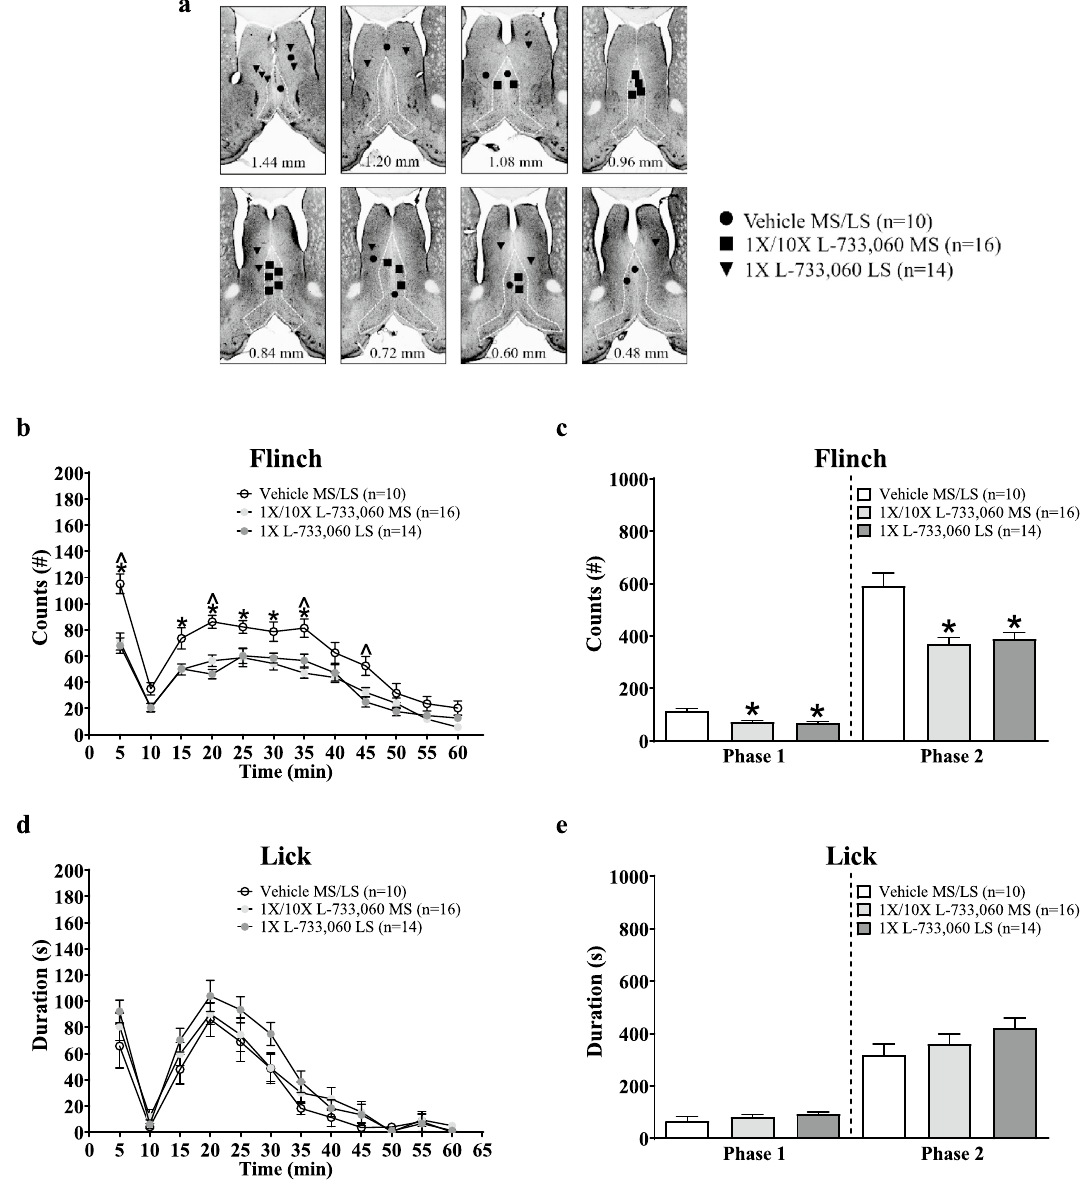
Figure 6. Intraseptal L-733,060 decreased nociceptive behaviours in the formalin test. In the behaving animal, formalin (1.25%, 0.1 ml) was injected into the right hind paw 15 min after microinjection of vehicle or L-733,060 into the medial (MS) or lateral (LS) septum (1 ×, 0.0176 µg/µl, MS, n = 9; LS, n = 14; 10 ×, 0.176 µg/µl, MS, n = 7). ( a ) Composite diagram of microinjection sites in the MS and LS built as in Fig. 1. ( b , d ) Time course graphs illustrating the biphasic (Phase 1, 1–5 min; Phase 2, 11–60 min) flinching and licking responses induced on injection of formalin. The behavioural response was binned in blocks of 5 min. ( c , e ) Histograms illustrating the cumulative number of flinches and cumulative duration of licking in Phases 1 and 2. Pre-treatment with L-733,060 in the MS and LS significantly attenuated formalin-induced flinching in phases 1 and 2 ( c ). However, the drug did not significantly affect licking ( e ). Data are mean ± S.E.M. Significant difference (p < 0.05): ( b , d ) *‘1 ×/10 × L-733,060 MS’ vs. ‘Vehicle MS/LS’ group, ^‘1 × L-733,060 LS’ groups vs. ‘Vehicle MS/LS’ group; two-way RM ANOVA followed by Bonferroni post-hoc test; ( c ) *vs. ‘Vehicle MS/LS’ group; one-way ANOVA followed by Newman–Keuls post-hoc